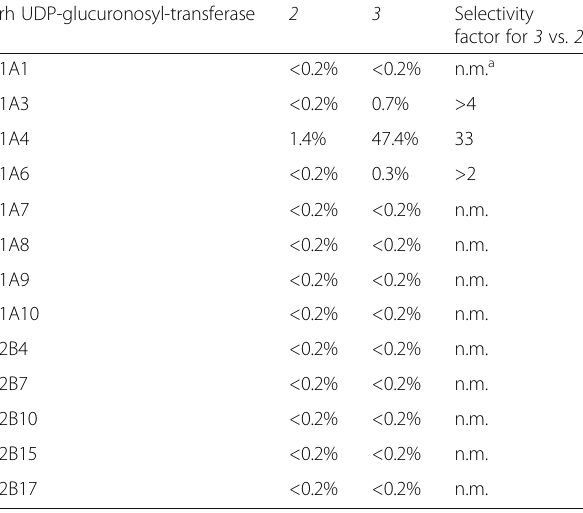
Table 2 Percentage of glucuronide formation with recombinant human UDP-glucuronosyltransferases in supersomes TM after 4 h (DAD at 240 nm) rh UDP-glucuronosyl-transferase Selectivity